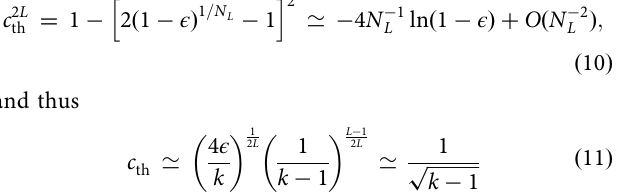
2D square lattices . In a 2D square lattice of n nodes ( the length of the m th shortest self-avoiding path, between